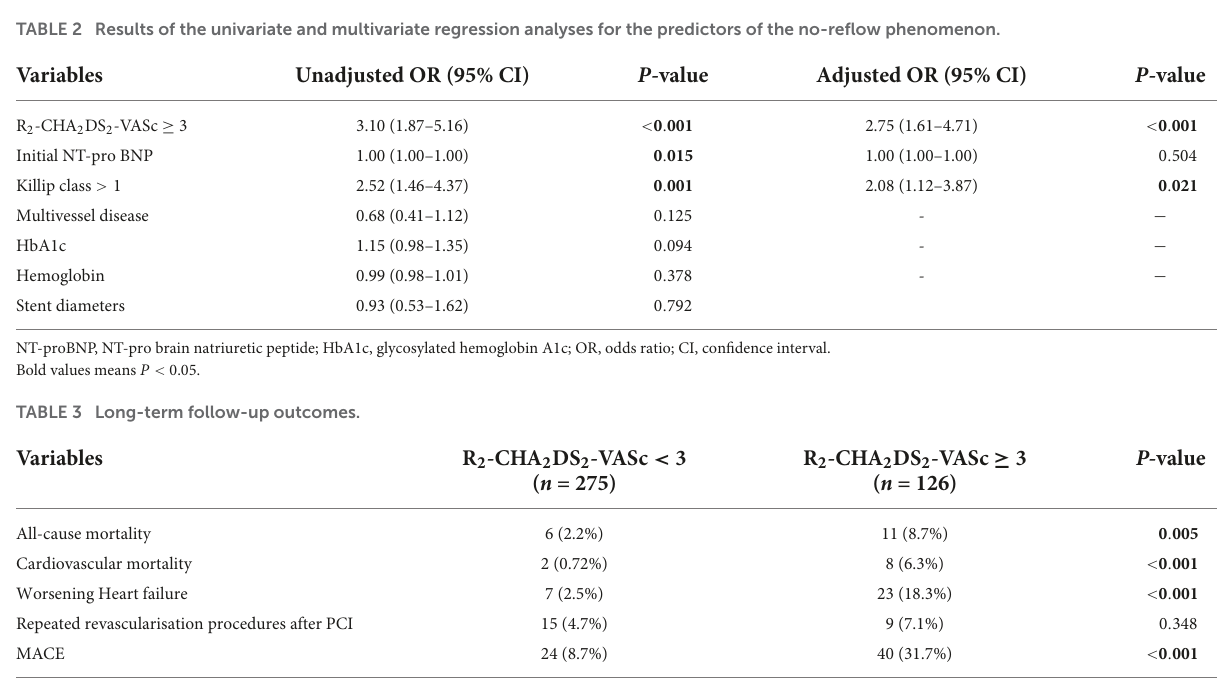
Table 1 summarized the baseline characteristics of the patients. Patients in R 2 -CHA 2 DS 2 -VASc ≥ 3 group tended to be older, predominantly male, and more likely to have a history of diabetes, hypertension, vascular disease, and stroke. heart failure between the two groups. Initial creatine kinase- density lipoprotein cholesterol, cardiac troponin I, leukocytes, platelets and creatinine values did not differ across groups.